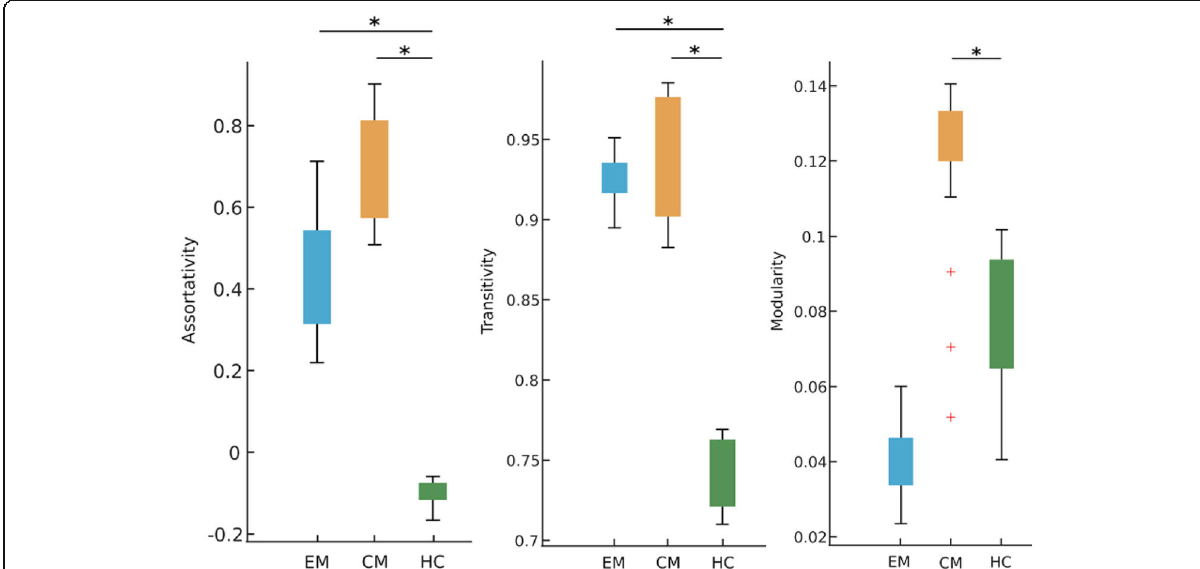
Fig. 3 Sub-cortical network results: Plots showing the network measures (assortativity, transitivity and modularity) significantly different between the groups: episodic migraine patients (EM), chronic migraine patients (CM) and healthy controls (HC) obtained using sub-cortical volumes. * indicates significant group differences at p < 0.05 (FDR corrected) and + indicates outliers (i.e. 2 standard deviations from the groups ’